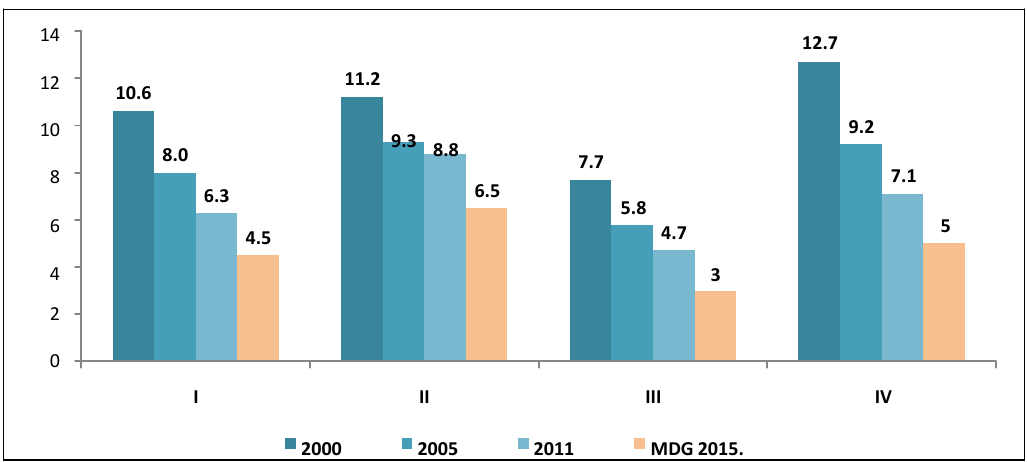
Figure 1. Children mortality rates in Serbia: Situation analysis and the desired Millennium Goal by